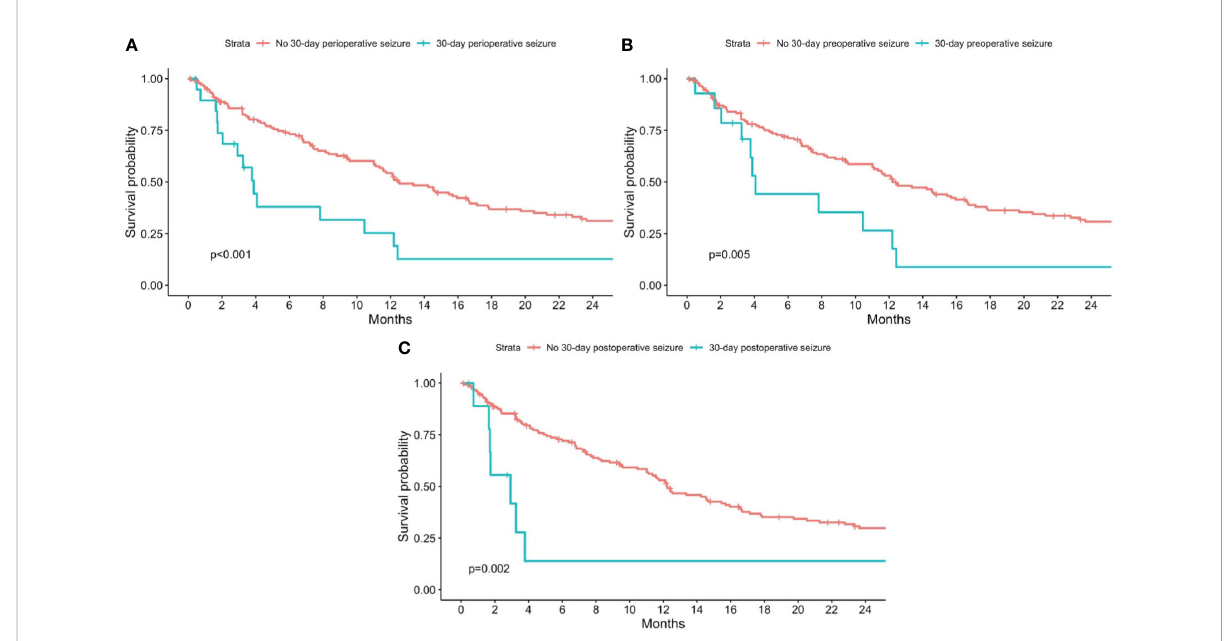
FIGURE 1 Kaplan-Meier curves for overall mortality strati fi ed by patients with and without 30-day perioperative seizures. Patients with no 30-day perioperative seizures are shown in red, while patients with (A) any 30-day perioperative seizure; (B) 30-day preoperative seizure; and (C) 30- day postoperative seizure are shown in blue. P-values from the log-rank test are shown in each fi gure